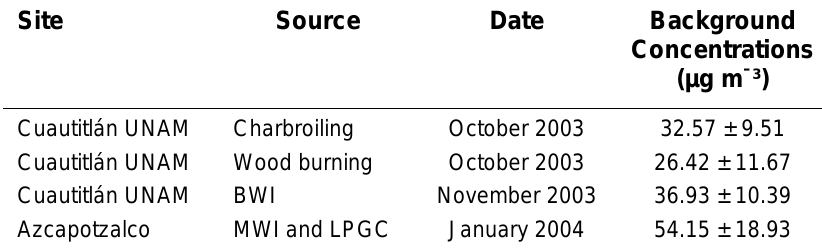
Background Upwind Concentrations during Emissions Source